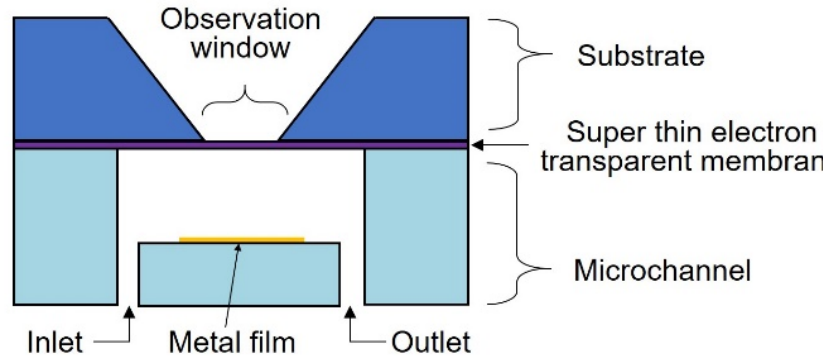
Figure 1. Schematic illustration of a microfluidic liquid cell with a super-thin